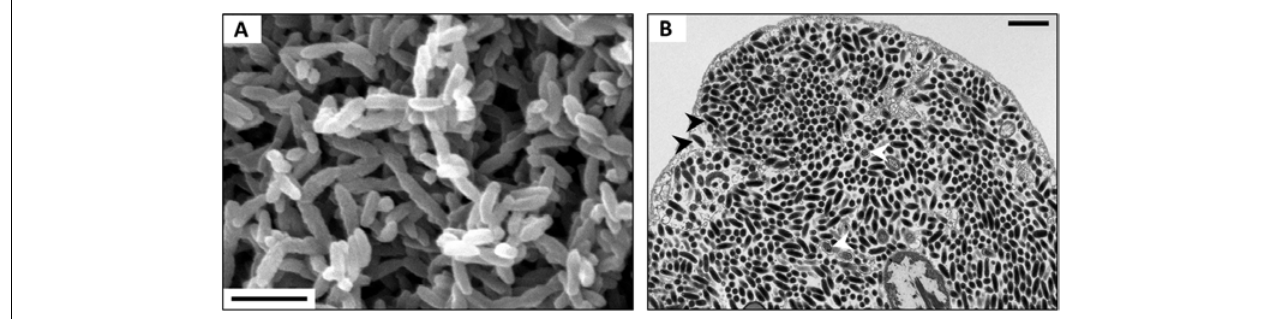
FIGURE 3 | (A) SEM of Rickettsiella in the hemolymph of P. scaber . (B) TEM of Rickettsiella in an ovary of Atlantoscia floridana , showing bacterial cells of two different stages: rod-shaped Elementary Bodies (black arrowheads) and replicative Reticulate Bodies (white arrowheads). Scale bar: 1 µ m. Picture credit: Maryline Raimond (A,B) and Bianca Lais Zimmermann (B)